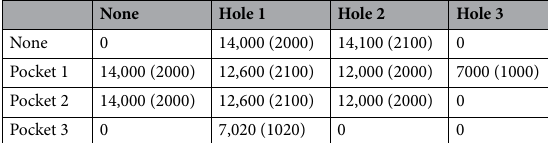
Table 3. The amount of data by category for the dataset.